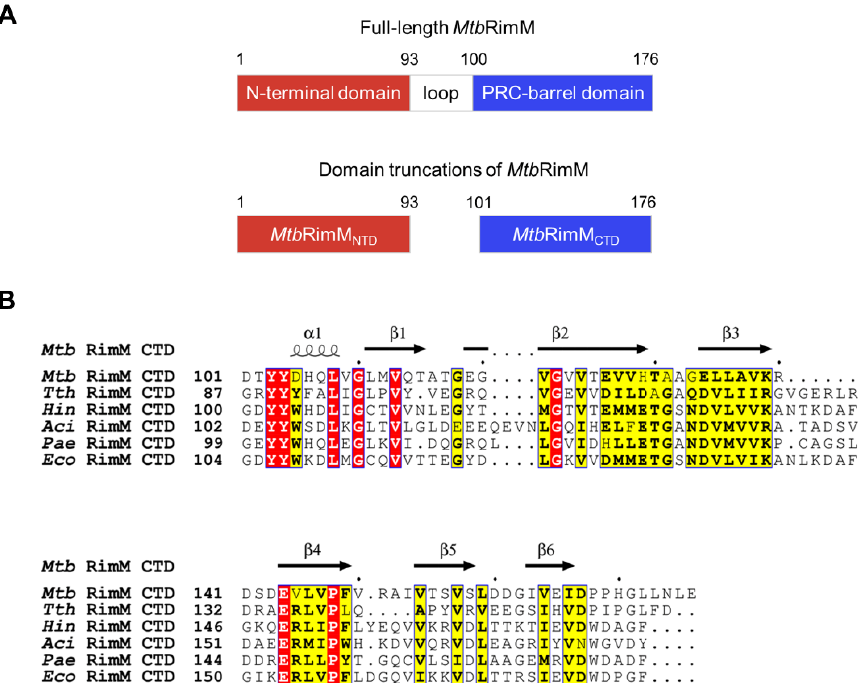
Figure 1. RimM consists of the N-terminal domain (NTD) and C-terminal domain (CTD). ( A ) Schematic diagram of two domains in RimM from Mycobacterium Tuberculosis ( Mtb RimM) predicted by Pfam. ( B ) Sequence alignments between CTDs of Mtb RimM and RimM orthologs. Identical residues are highlighted in red and similar residues in yellow, and secondary structure elements of the CTD of Mtb RimM ( Mtb RimM CTD ) resolved in this study (see Section 3.1) are shown above the alignments.